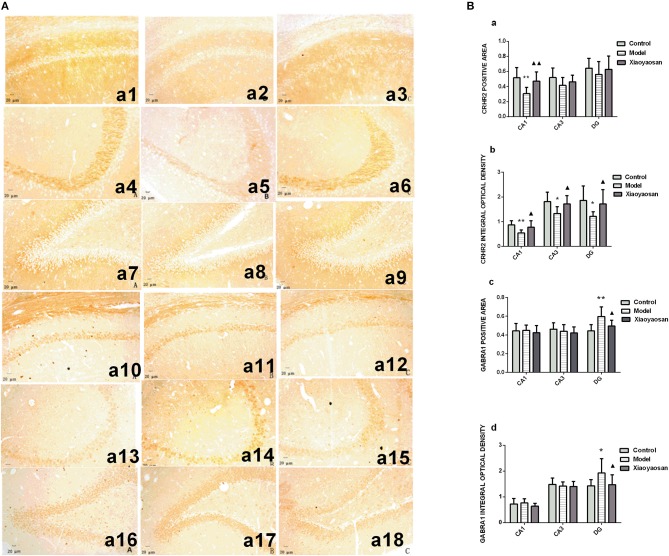
Effects of Xiaoyaosan on the levels of the CRHR2 and GABRA1 proteins in the rat hippocampus. (A) Levels of the CRHR2 and GABRA1 proteins in the hippocampal CA1, CA3, and DG regions. Levels of the CRHR2 protein in hippocampal CA1
(a1–a3), CA3
(a4–a6), DG (a7–a9) regions of the control, model, and Xiaoyaosan groups. Levels of the GABRA1 protein in the hippocampal CA1
(a10–a12), CA3
(a13–a15), DG (a16–a18) regions of the control, model, and Xiaoyaosan groups. (B) Changes in the levels of the CRHR2 and GABRA1 proteins in the rat hippocampus. (a) CRHR2-positive area. (b) Integrated optical density of the CRHR2 protein. (c) GABRA1-positive area. (d) Integrated optical density of the GABRA1 protein. Values are presented as the means±SD from 10 rats per group. *P < 0.05 and **P < 0.01 compared with the control group. ▴P < 0.05 and ▴▴P < 0.01 compared with the model group.